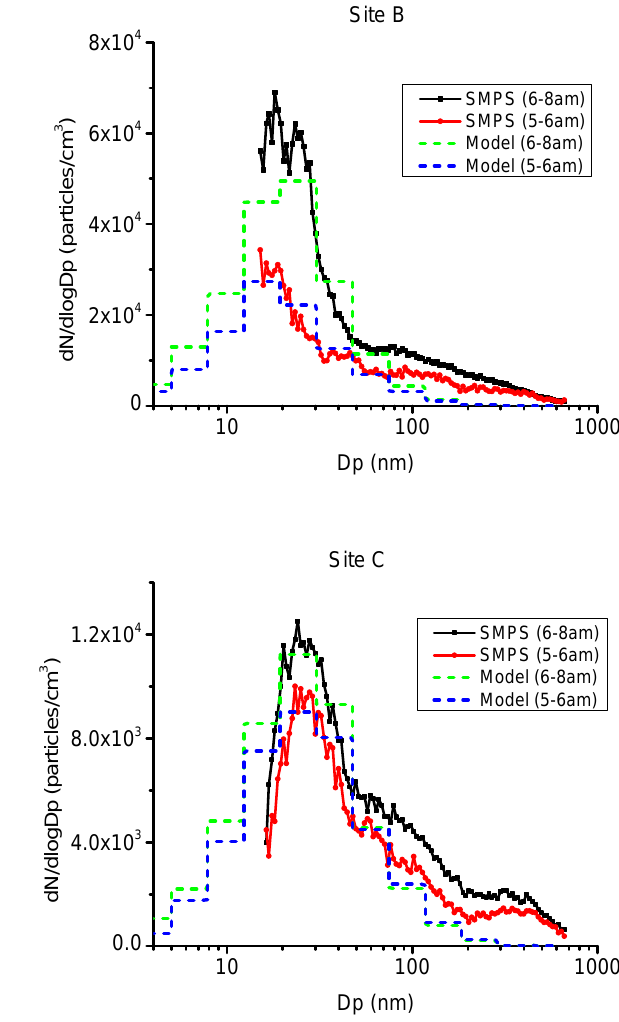
Figure 4. Comparison of modeled and measured near-road concen- Fig. 4. Comparison of modelled and measured near-road concentrations of CO 2 (ppmv) 4 trations of CO 2 (parts per million volume, ppmv) and BC (µgm − 3 ) on the downwind side of Hwy 400. Median concentrations from FEVER measurements are plotted in black solid lines, and mod- and BC (µg/m 3 ) on the downwind side of Hwy-400. Median concentrations from FEVER 5 eled concentrations are plotted in red dashed lines. The gray areas represent measurements within 25th and 75th percentiles. measurements are plotted in black solid lines, and modelled concentrations are plotted in 6 red dashed lines. The grey areas represent measurements within 25 th and 75 th percentiles. 7